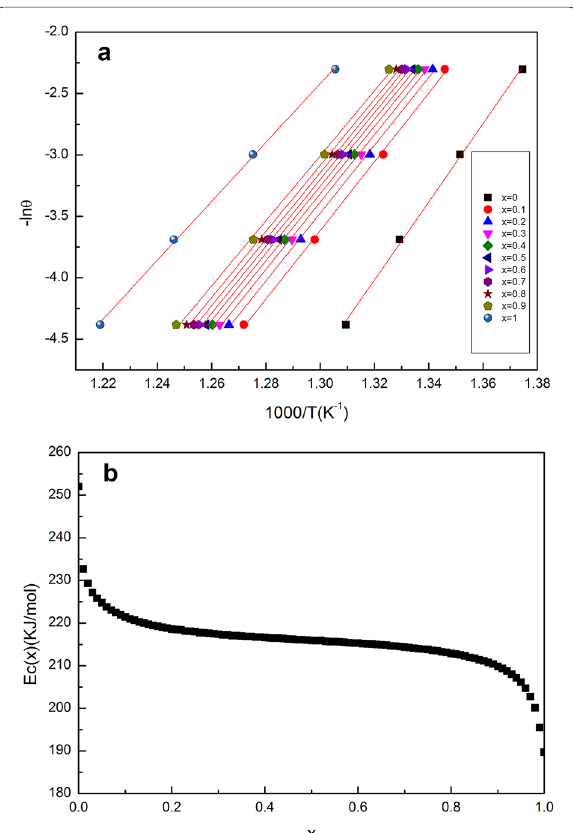
Figure 6 Non-isothermal crystallization of Zr 63 Fe 2.5 Cu 23 Al 11.5 BMG under different heating rates: a plots of ln( θ ) vs. 1000/ T with different volume fractions of crystallization; b plot of local activation energy as a function of x based on the Ozawa–Flynn–Wall